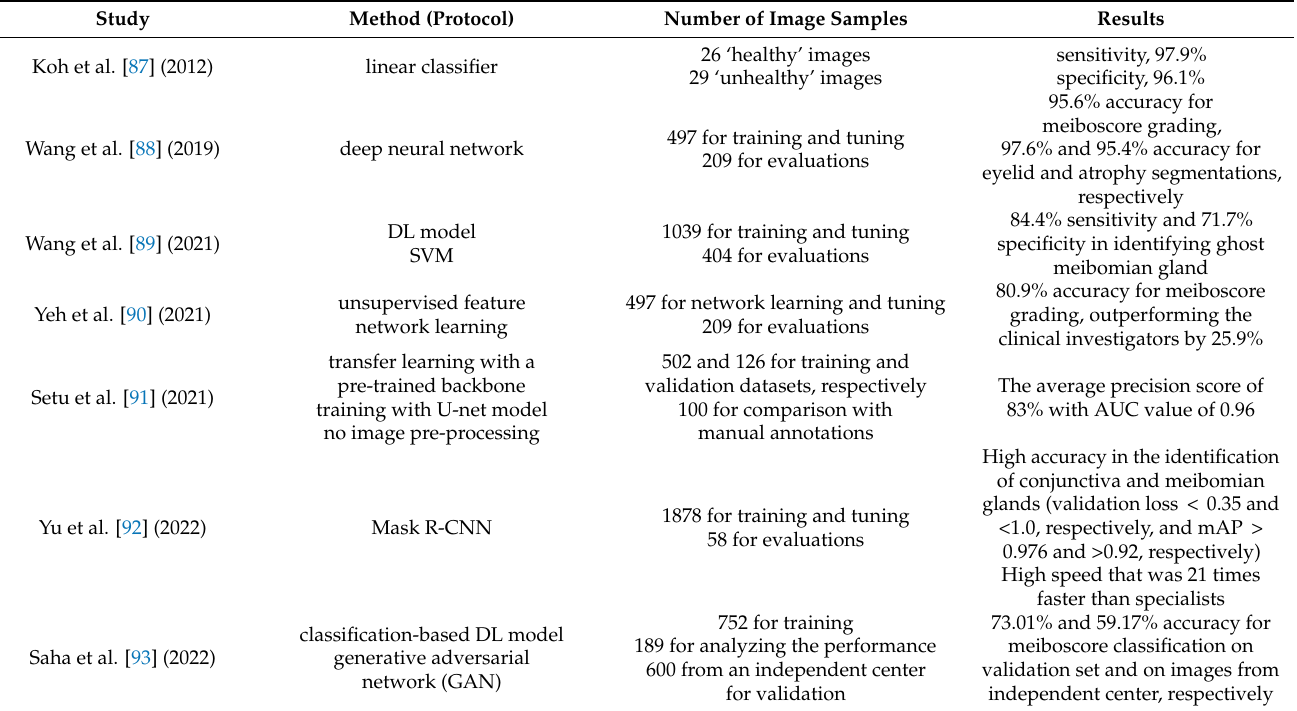
Table 2. Summary of the studies regarding application of AI for analysis of meibography